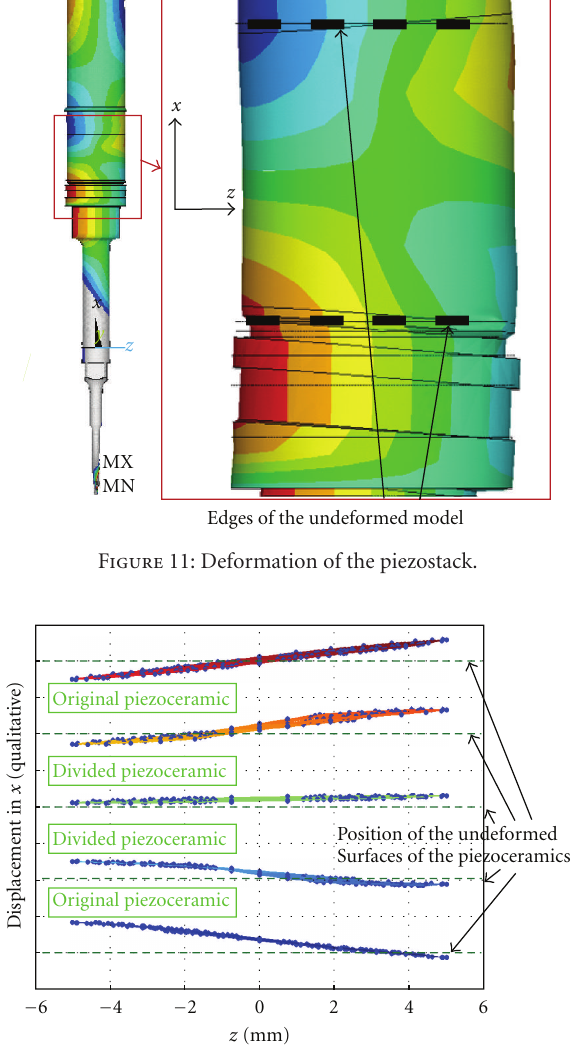
Figure 12: Surfaces of the deformed